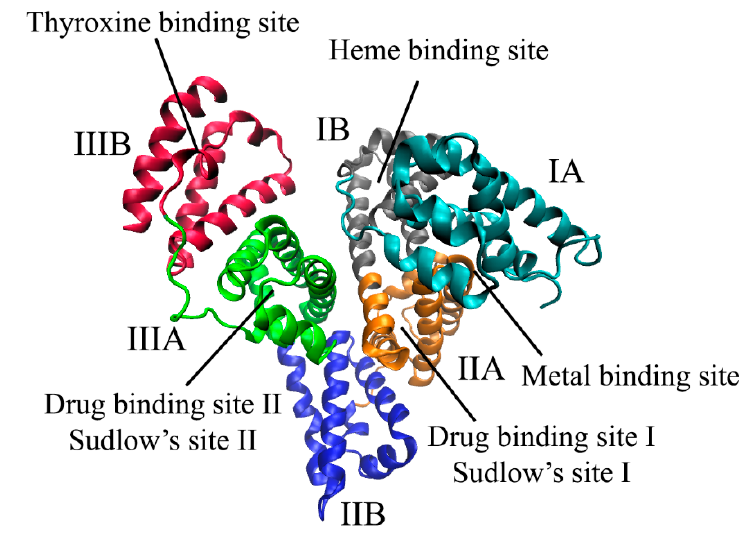
Figure 1. Positions of binding sites in a bovine serum albumin molecule.